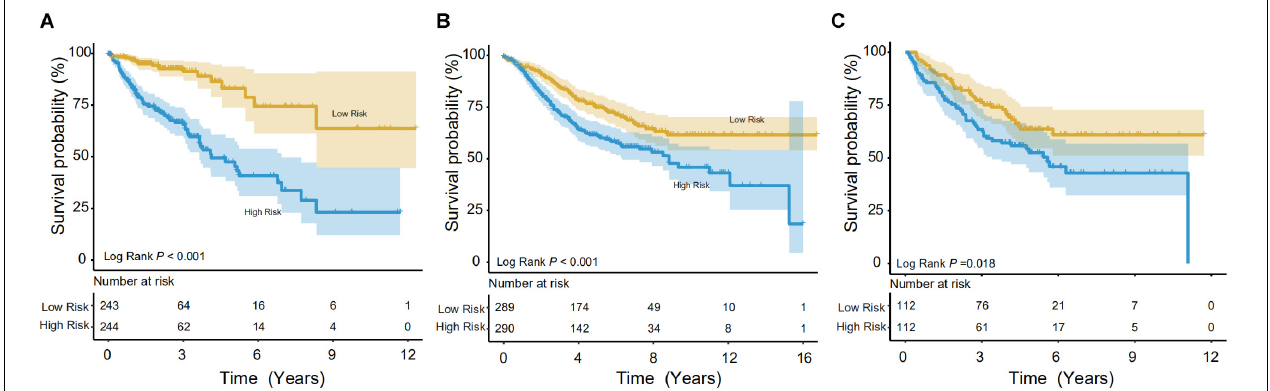
FIGURE 3 | Survival analysis in the training and validation datasets. The Kaplan-Meier (KM) test was performed on the training and validation data to verify survival between high- and low-risk populations. (A) In the training group (TCGA), the model showed good discrimination ( p < 0.001). (B,C) In both validation groups (GSE39582 and GSE17538, respectively), the low-risk population showed significantly better survival.